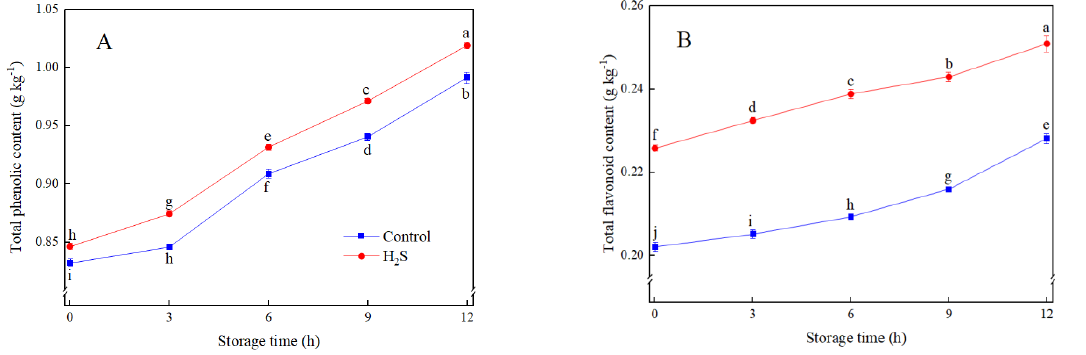
Figure 1. Effects of H 2 S treatment on the content of total phenolic ( A ) and total flavonoid ( B ) of fresh-cut peaches during storage. Data are presented as mean ± standard errors of triplicate samples. Different letters indicate statistically significant ( p < 0.05) differences.